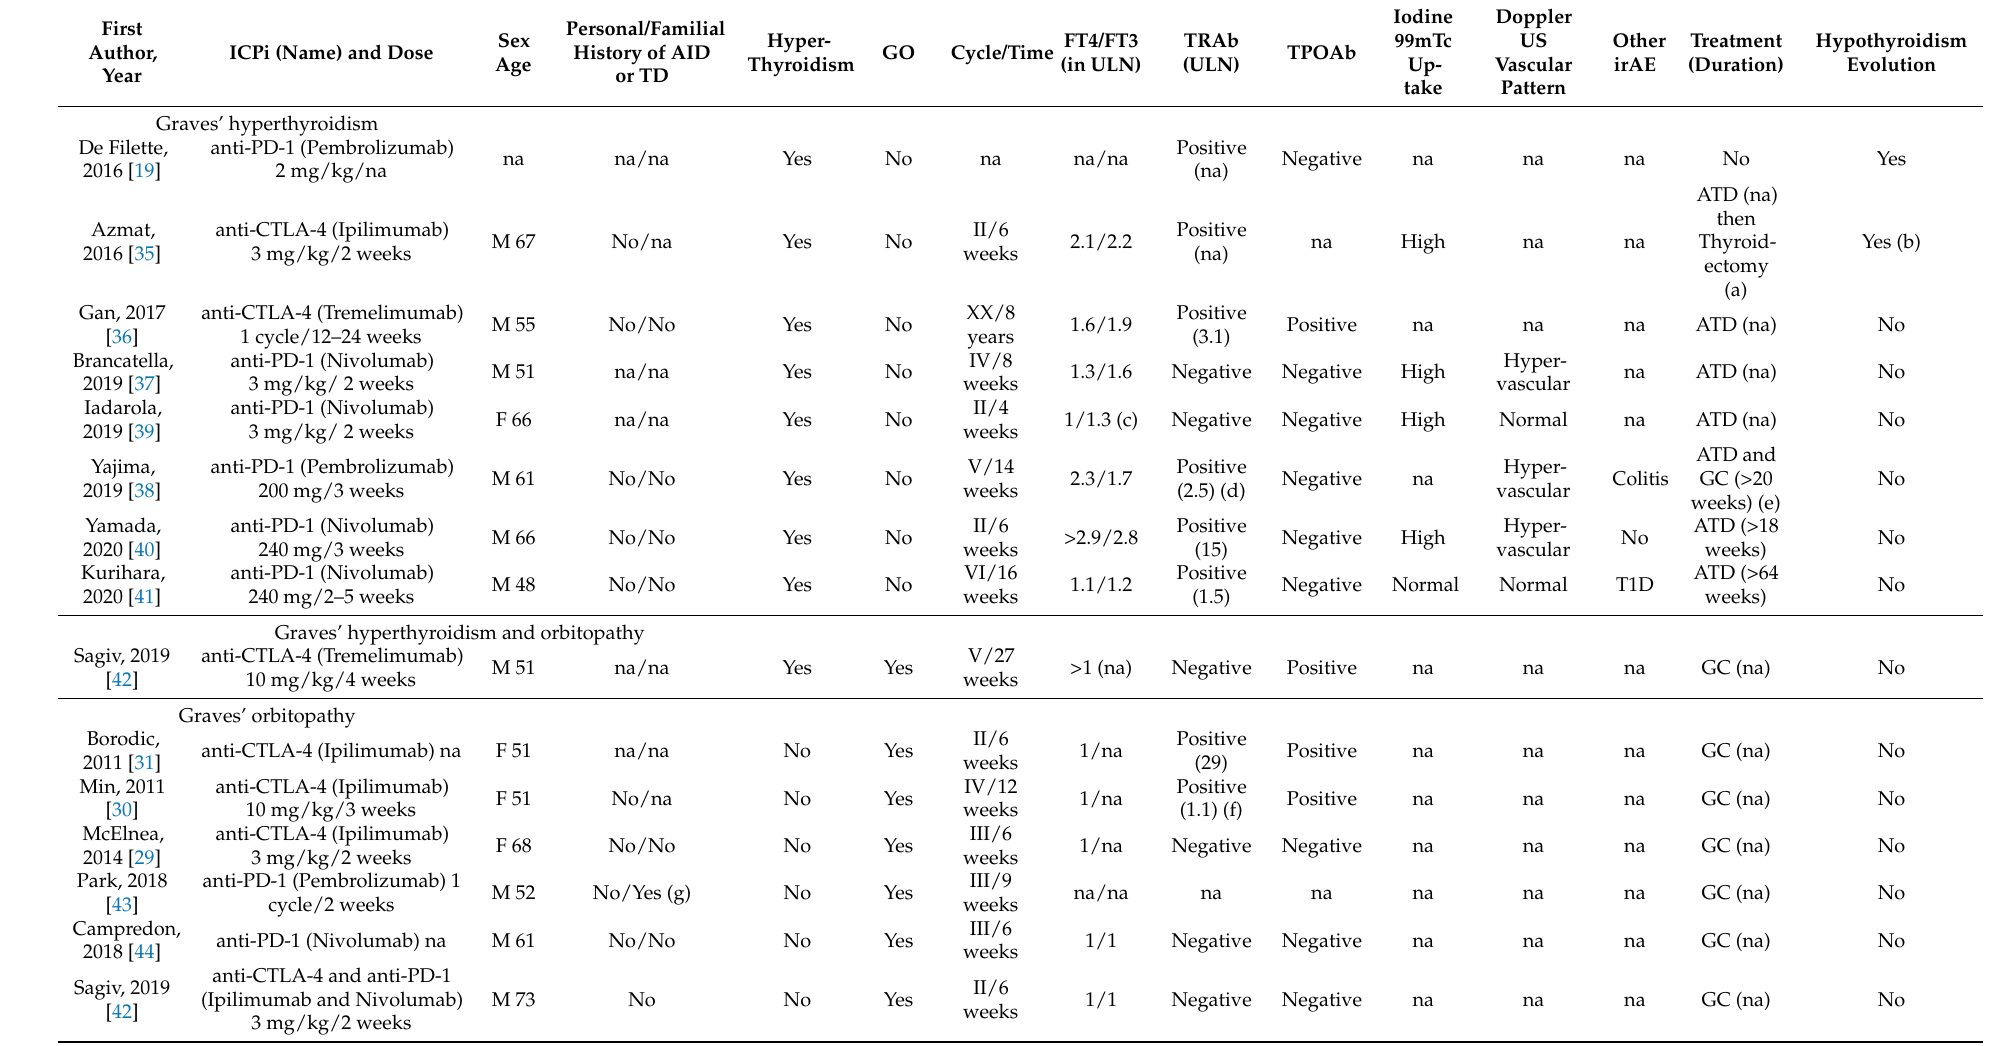
Table 3. Review of the literature: case reports of Graves’ hyperthyroidism or orbitopathy induced or during ICPi